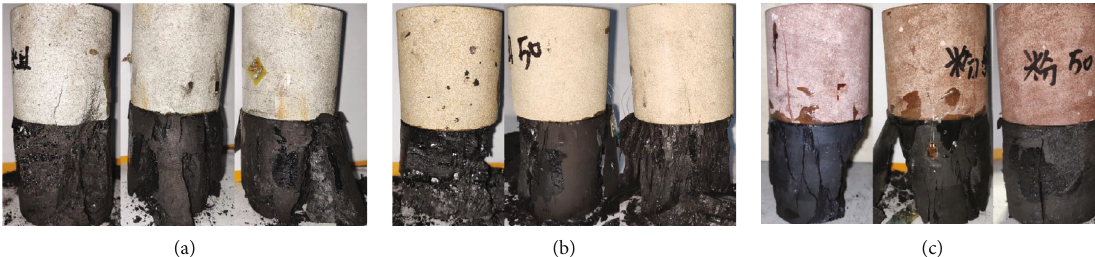
Figure 9: The failure modes of the coal – rock combination sample structures with di ff erent lithologies: (a) coarse sandstone-coal; (b) fi ne sandstone-coal; (c) siltstone-coal.